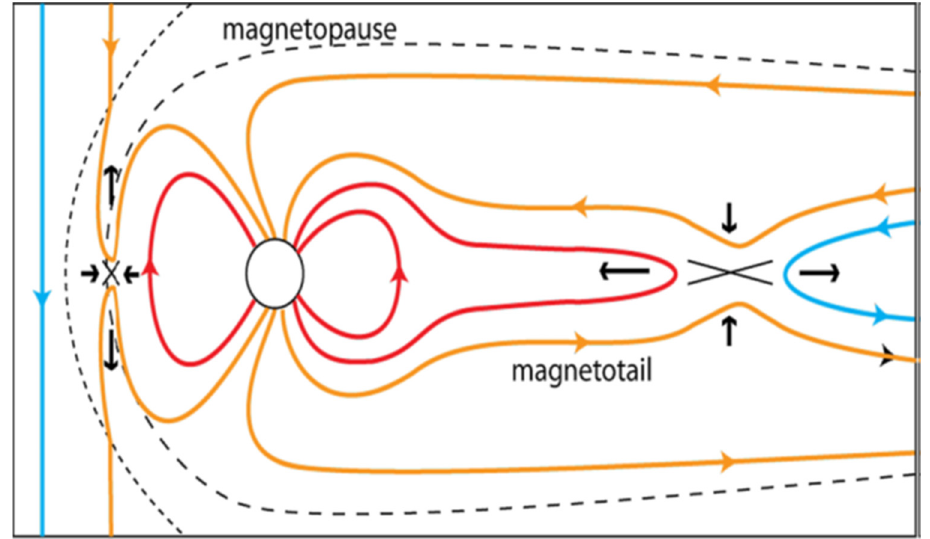
Figure 6. A schematic of plasma circulation in the Earth’s magnetosphere for southward IMF conditions [36].